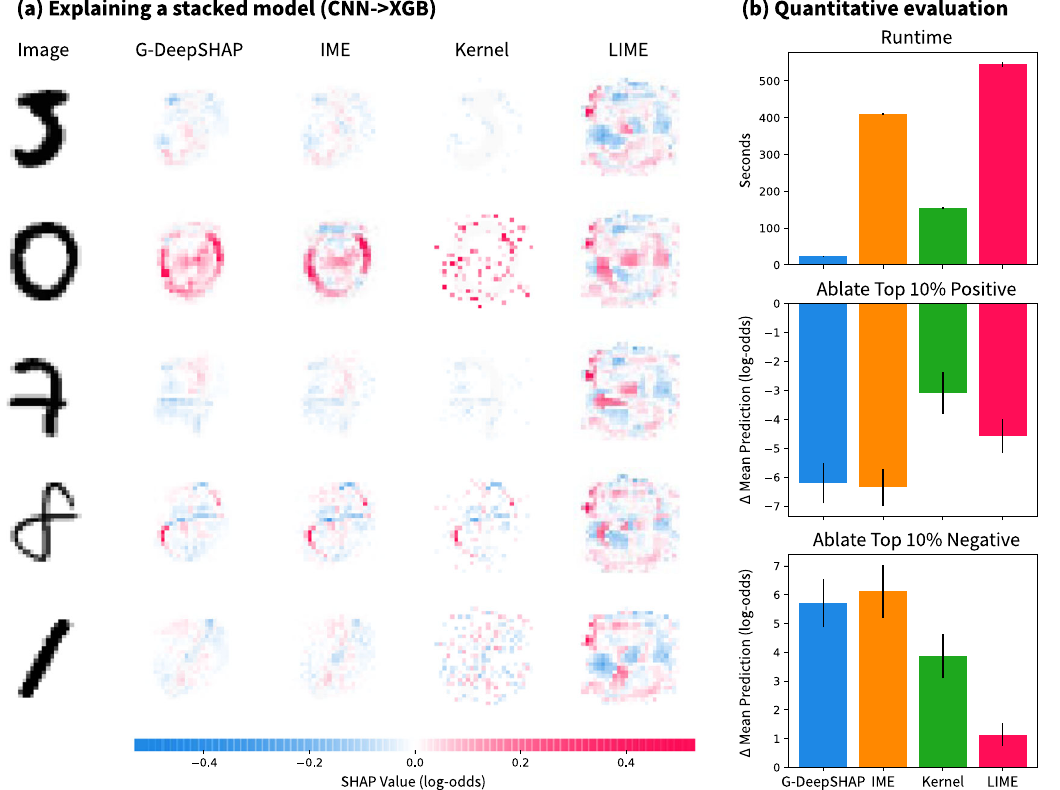
Fig. 6 Explaining a series of models comprised of a convolutional neural network feature extractor and a gradient boosted tree classi fi er. a Explanations from G-DeepSHAP and state-of-the-art model-agnostic approaches. b Quantitative evaluation of approaches, including runtime and ablation of the top 10% of positive and negative features. Error bars are 95% con fi dence intervals based on 20 iterations of randomly drawing fi ve explicand images, then computing attributions and ablation